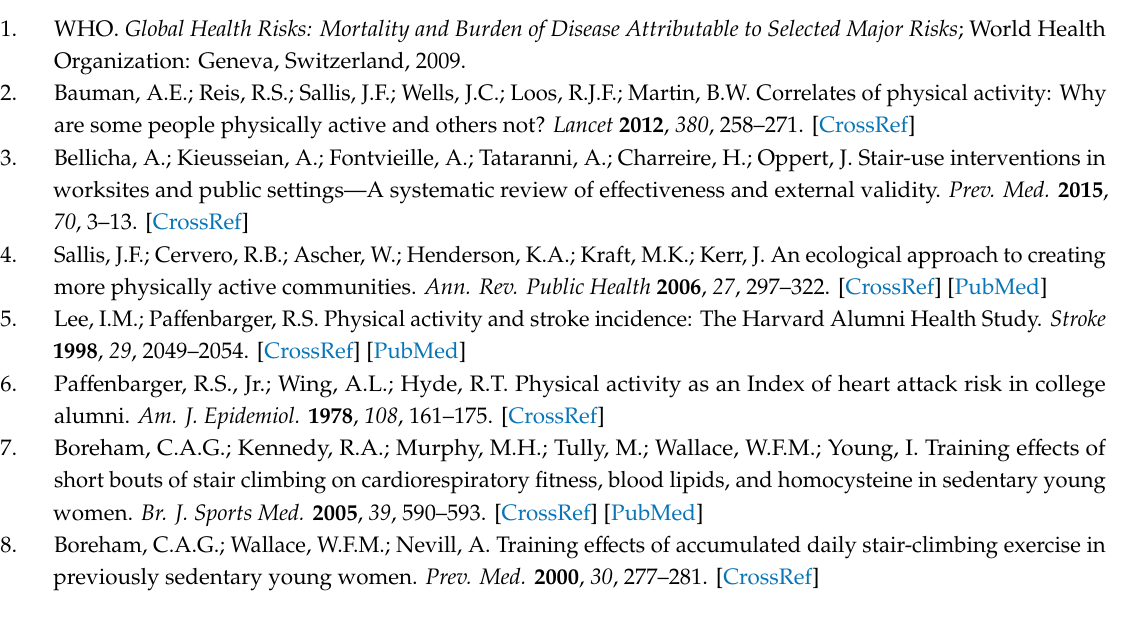
Supplementary file 1: Summary of building characteristics, pedestrian behavior, and stair climbing campaigns in the UK. Supplementary file 2: Summary of building characteristics, pedestrian behavior, and stair climbing campaigns for Barcelona, Spain. Supplementary file 3: Discussion of the e ff ects of pedestrian movement on stair